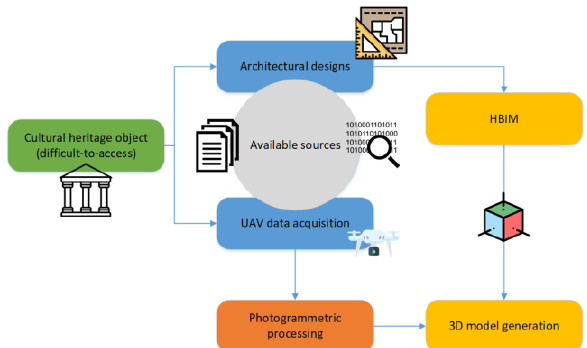
Figure 3: Workflow of the BIM generation of Averof’s Museum, Metsovo,